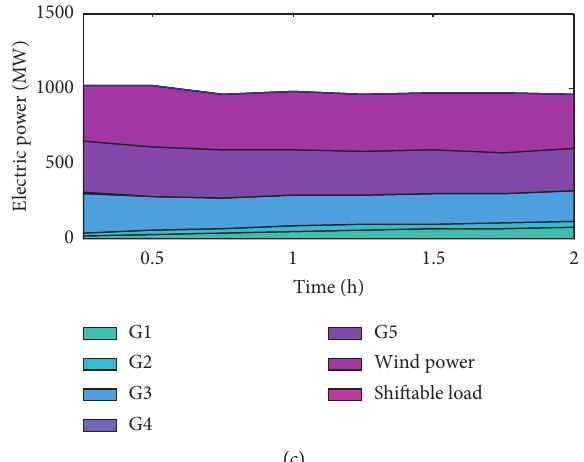
Figure 4: Intraday scheduling results of the next 2hours: (a) forecasted wind power; (b) whole-horizon intraday scheduling; (c) next 2-hour intraday scheduling without considering the whole horizon.